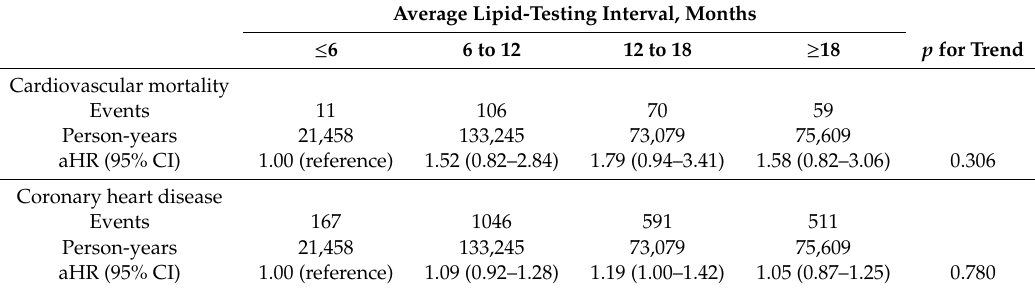
Table A2. Hazard ratios for cardiovascular mortality and coronary artery disease according to average lipid-testing interval among newly diagnosed dyslipidemia